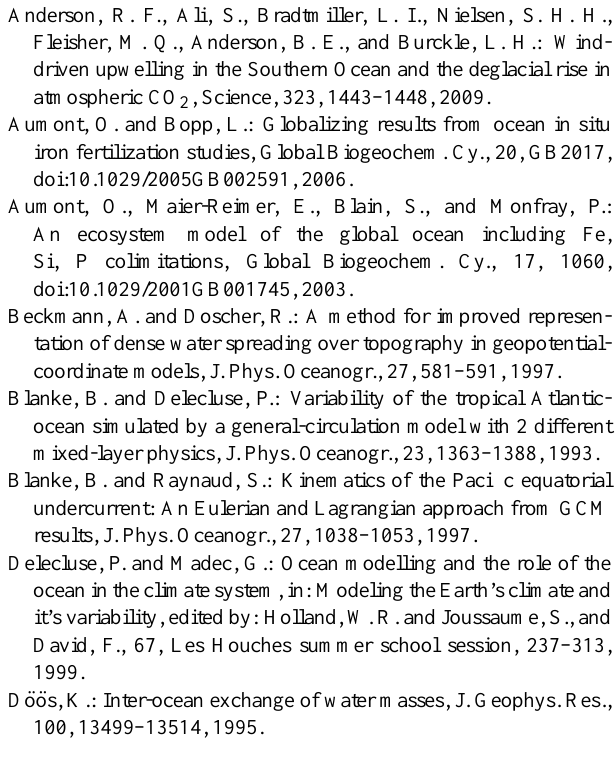
Fig. A2. Upper panel: GLODAP alkalinity section at 30 ◦ S. Lower panel: PISCES alkalinity section at 30 ◦